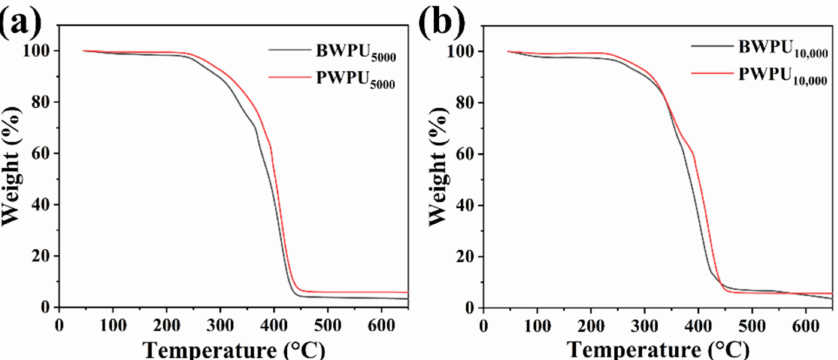
Figure 5. ( a ) TGA curves of BWPU 5000 film and PWPU 5000 film; ( b ) TGA curves of BWPU 10,000 film and PWPU 10,000 film. Table 3. Data of thermal decomposition of BWPU 5000 , PWPU 5000 , BWPU 10,000 and PWPU 10,000 .